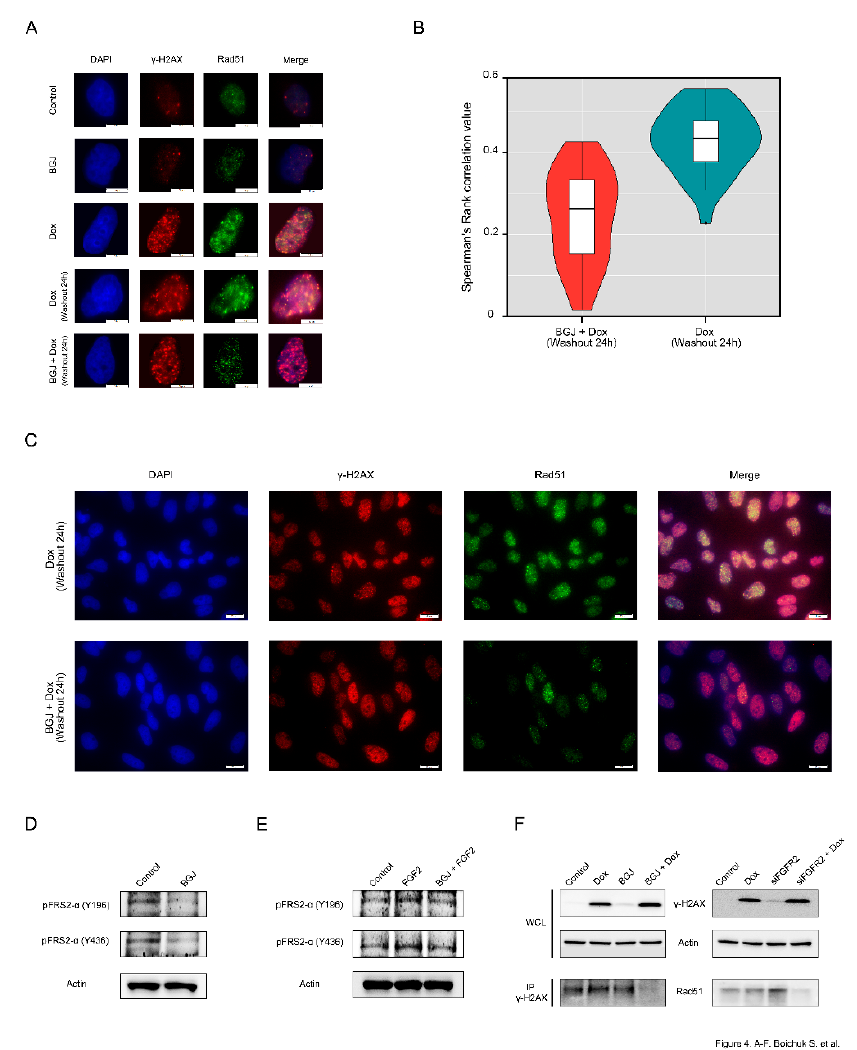
Figure 4. Inhibition of FGF-signaling impairs RAD51 loading to DNA DSBs: ( A ) GIST T-1R cells were pretreated with Dimethyl Sulfoxide (DMSO) (control) or BGJ398 (1 µ M) for 48 h prior doxorubicin treatment (0.25 µ g / mL) and 4 h later processed for immunofluorescence using Rad51 and γ -H2AX. DAPI staining was used to outline the nucleus (Scale bars = 10 µ m). ( B ) Graph illustrating the distributions of Spearman’s rank correlation values between GIST T1-R cells treated with Dox alone (mean = 0.429) or in presence of BGJ398 (mean = 0.245). p value = 9.816e-10 ( t -test). ( C ) Immunofluorescence staining for H2AX and Rad51 was performed on Dox-treated GIST cells after DMSO (control) or BGJ398 treatment. A wider field of cells is shown (scale bars = 20 µ m). BGJ398 inhibits FGFR-signaling in IM-resistant and naïve GIST cells: ( D ) BGJ398 abolishes the FGFR-signaling in IM-resistant GIST T-1R cells. The cells were treated with DMSO (control) and BGJ398 (1 µ M) for 72 h and were further subjected to immunoblotting with phosphorylated forms of FRS-2 antibodies. ( E ) BGJ398 abrogates FGF-2-induced activation of FGFR-signaling in IM-resistant GIST T-1 cells. The cells were treated with DMSO (control), FGF-2 (100 ng / mL) alone or in presence of BGJ398 (1 µ M) for 72 h and were further subjected to immunoblotting with phosphorylated forms of FRS-2 antibodies. ( F ) GIST T-1R cell lysates were immunoprecipitated with γ -H2AX Abs and immunoblotted with Rad51 Abs to demonstrate endogenous complex formation. A whole cell lysate (WCL) was included. Actin was used as a loading control. Inhibition of FGF-signaling was achieved by using BGJ398, a selective FGFR 1-4 inhibitor (left), or siRNA against FGFR2 (right). GIST T-1R cells were pre-treated with BGJ398 1 µ M (left) or transfected with siFGFR2 (right) for 48 h before Dox treatment (1 µ g / mL for 24